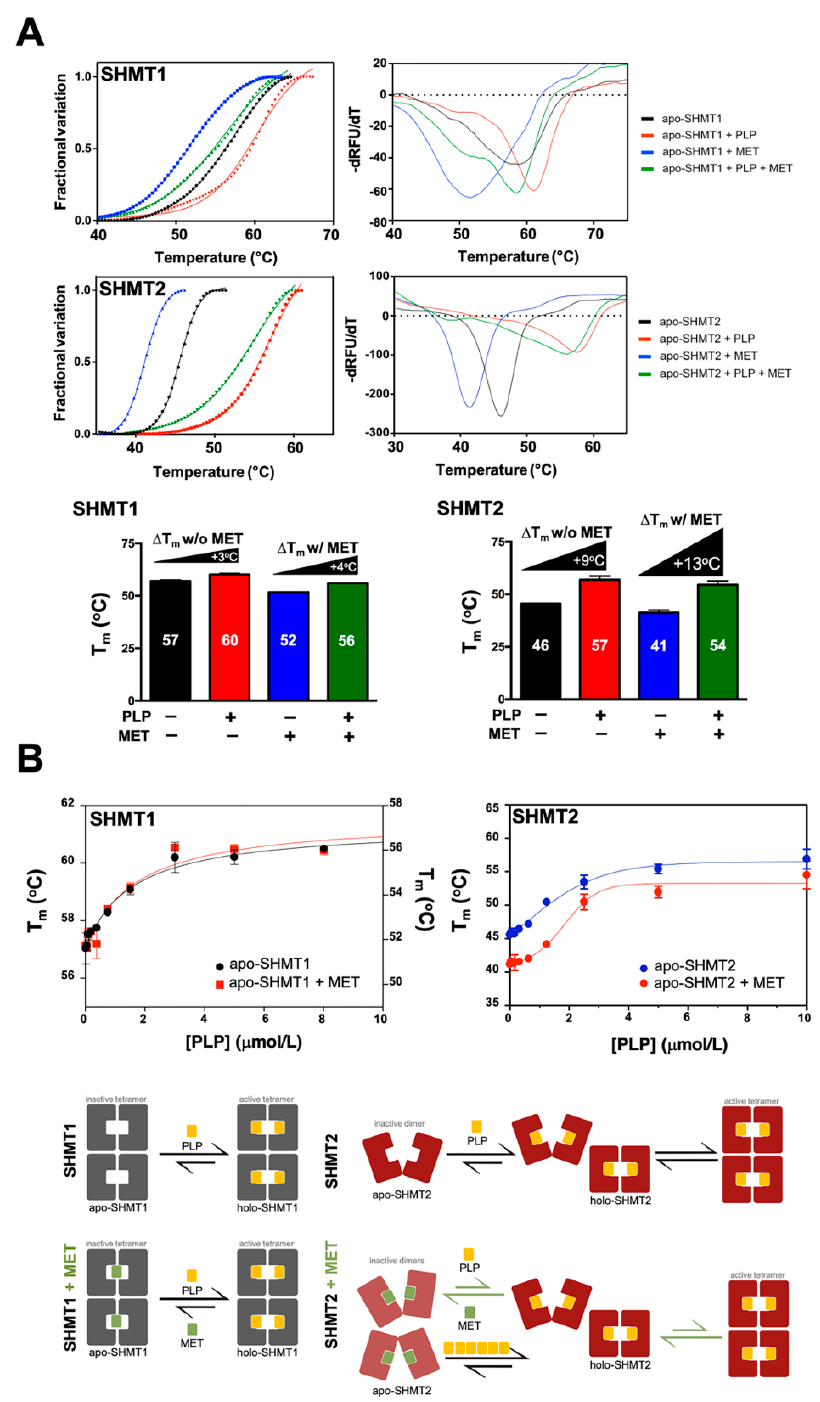
Figure 3. Metformin regulates SHMT2 dimer–tetramer transition. ( A ) Top. Differential scanning fluorimetry (DSF) analysis of apo-SHMT1 and apo-SHMT2 (0.5 µ mol/L each) in the absence and presence of PLP (10 µ mol/L) and/or MET (200 mmol/L). Bottom. Melting temperatures (T m ) for each of the conditions shown in left panels. Changes in melting temperatures ( ∆ T m ) were calculated by subtracting the T m of SHMT1/2 with buffer and without PLP from the T m of SHMT1/2 with added PLP in the absence and presence of MET. ( B ) Top . T m of apo-SHMT1/2 with increasing concentrations of PLP (0–10 µ mol/L) in the absence and presence of MET. Bottom. Computational- and DSF-based conceptual model of the ability of metformin (MET) to differentially impact the SHMT2 dimer–tetramer equilibrium in response to PLP while sparing the SHMT1 PLP-independent constitutive